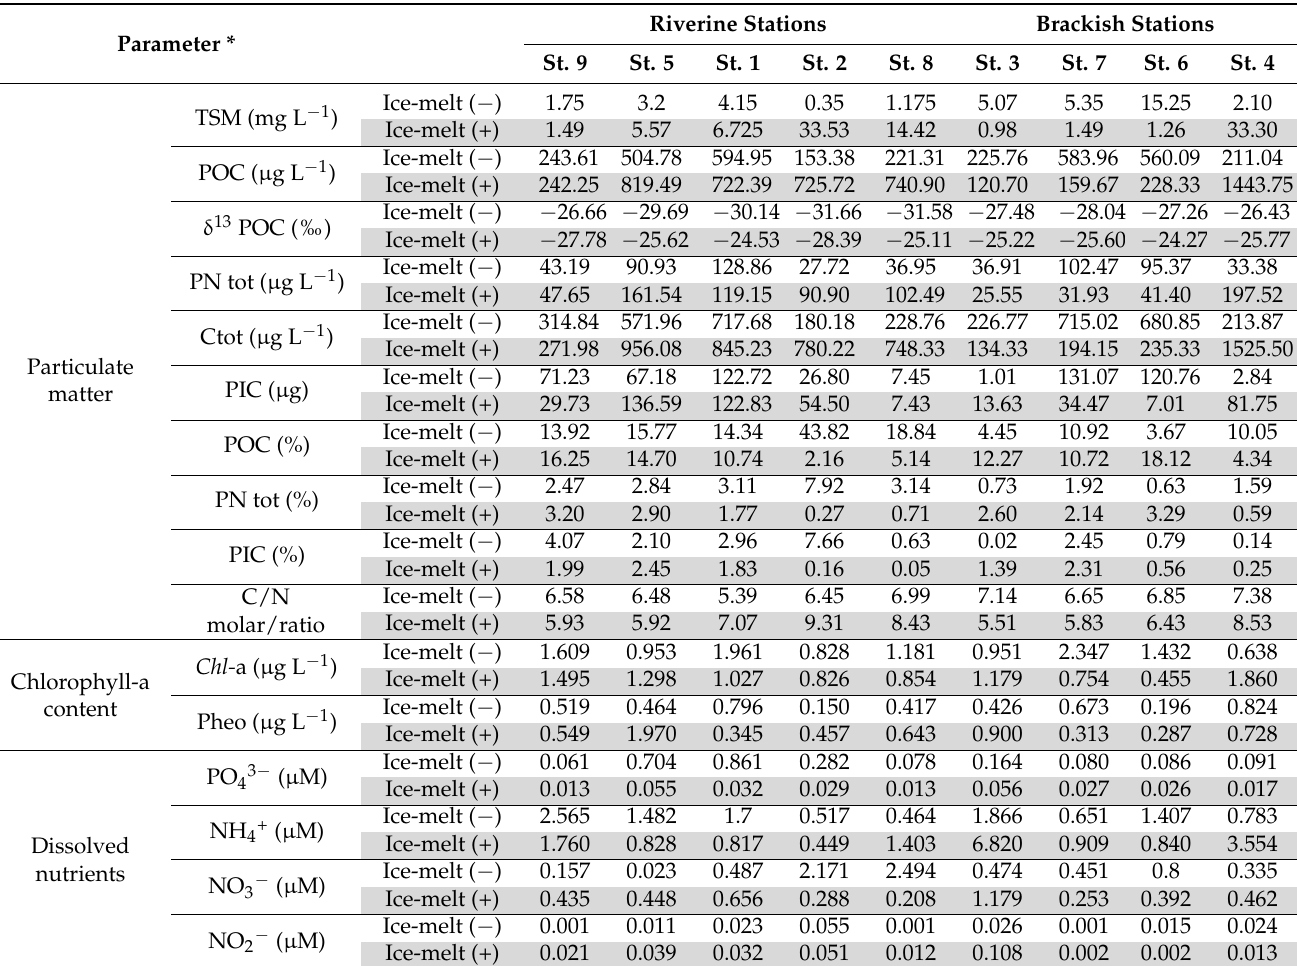
Table 2. Environmental chemical variables in water samples collected in May (Ice-Melt ( − )) and July (Ice-Melt (+)) 2014 along the Pasvik